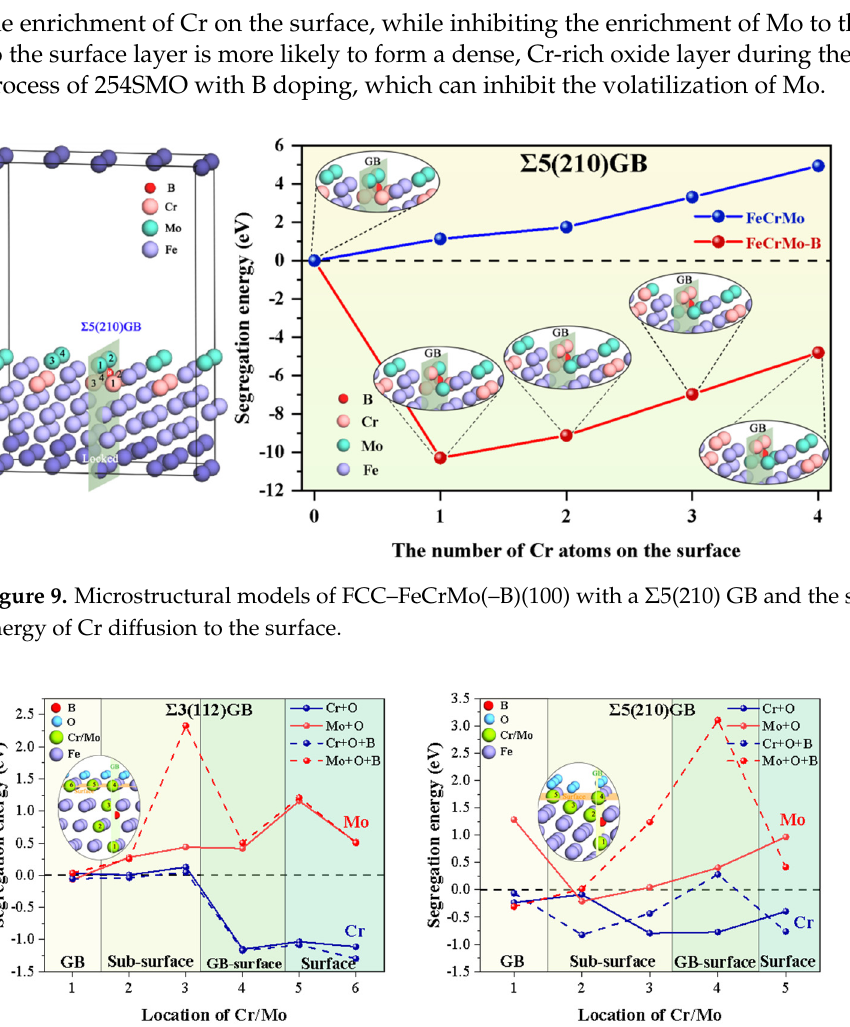
Figure 9. Microstructural models of FCC–FeCrMo(–B)(100) with a Σ 5(210) GB and the segregation energy of Cr diffusion to the surface.